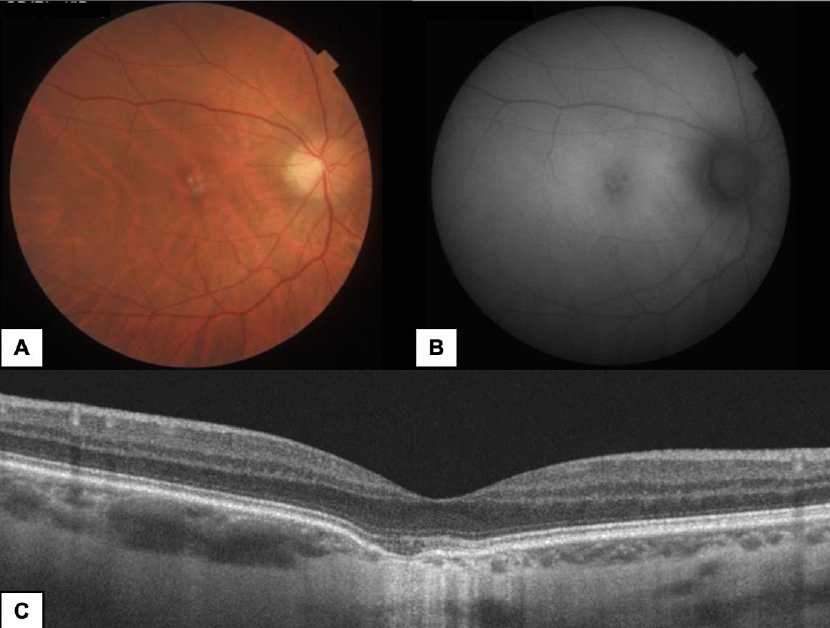
Figure 1. A 35-year-old woman with subfoveal FCE type 1 in the right eye (RE). ( A ) Color fundus photography — yellowish lesion in the center of macula. ( B ) FAF — irregular hypoautofluorescence in the area of FCE. ( C ) OCT B-scan — conforming FCE with RPE atrophy and choroidal thinning at the base of FCE.